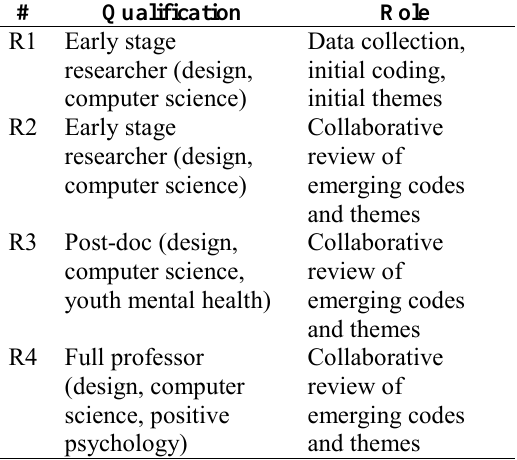
Figure 2. Intermediate step of thematic analysis Table 1. Researchers involved in data